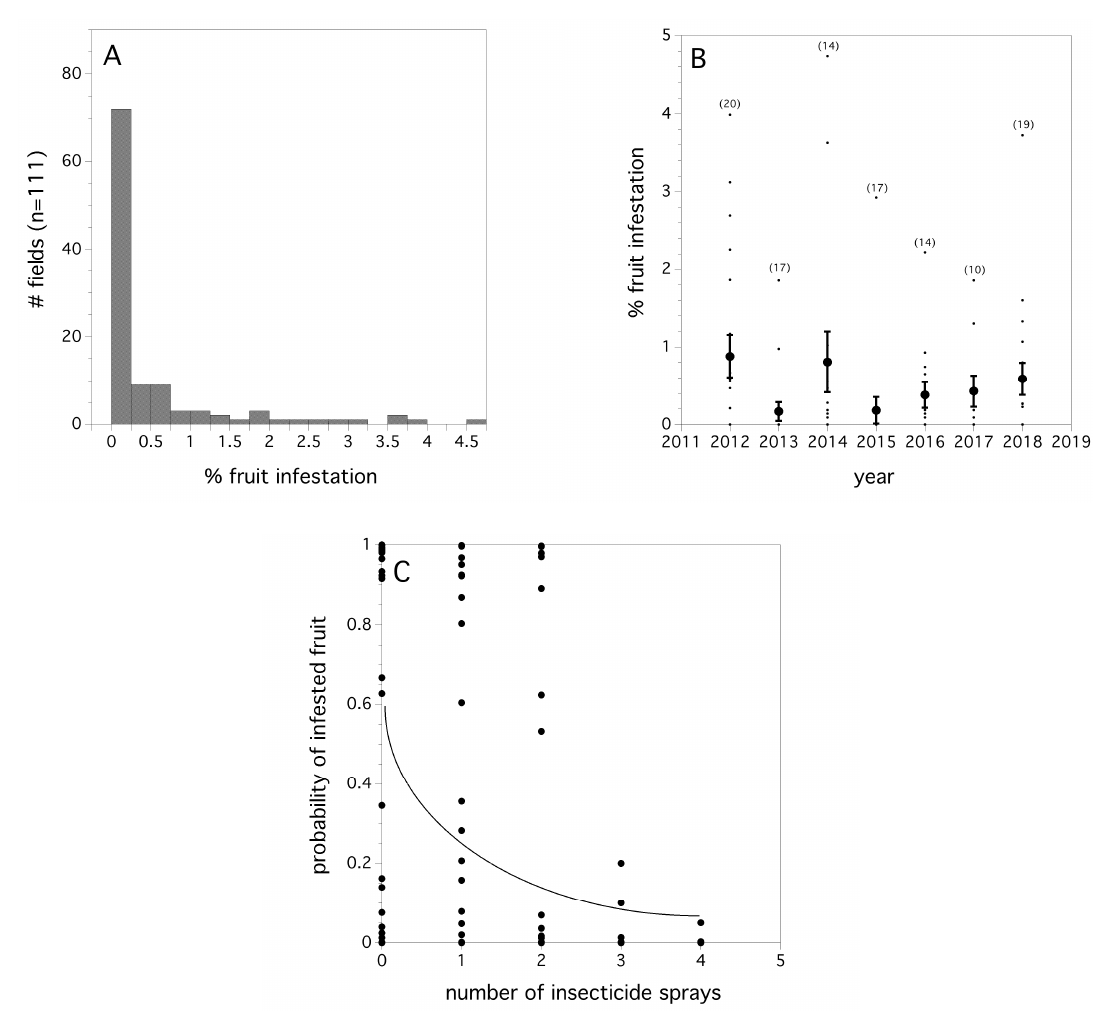
Figure 5. Empirical frequency distribution of fruit infestation levels (%) per field over all years ( A ); the percent fruit infestation in individual fields by year, small filled circles are individual field infestation rates and large filled circles are annual means (error bars are standard errors) ( B ); and the relationship between model estimated probabilities of infested blueberry fruit in a field and the number of insecticide applications applied. Solid line is predicted logistic regression fit ( C ).